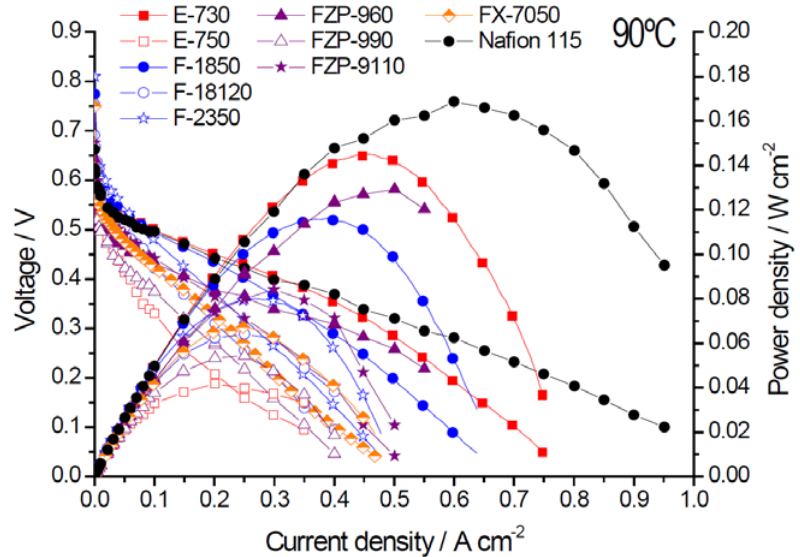
Figure 3. Polarization and power density curves for the different membranes in MEAs at 90 °C, 2 M